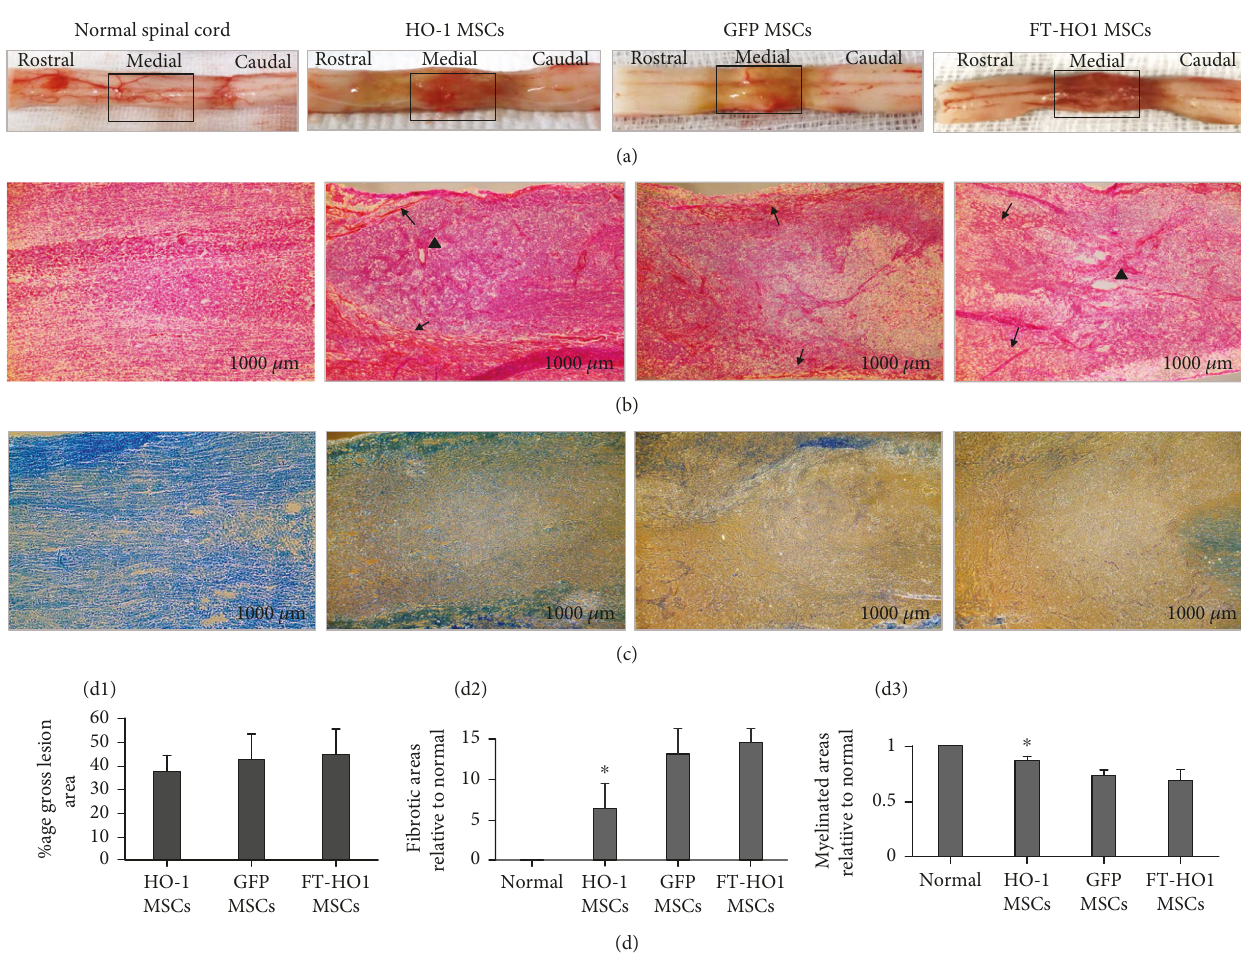
Figure 8: Histopathology of injured spinal cords stained with H&E and luxol fast blue. (a) Injured spinal cord segments with fi brosis, hypotrophy, and hemorrhages. (b) Representative H&E staining of injured spinal cord segments. The fi brotic area is observed as a red & pink color, while the healthy area is observed as purple. (c) Representative staining of myelin with luxol fast blue. Positive staining is depicted by the intensity of the blue color. The images were obtained at low magni fi cation 40x with a scale bar of 1000 μ m. (d1) % expression of gross lesion area. (d2) % expression of fi brosis relative to normal. (d3) % expression of the myelinated area relative to normal. Each bar represents the average of 4 samples per group. ∗ Represents the signi fi cance of the HO-1 MSC with the GFP MSC and FT-HO-1 MSC groups at p ≤ 0 05 . Arrows denote fi brotic areas; arrowheads denote